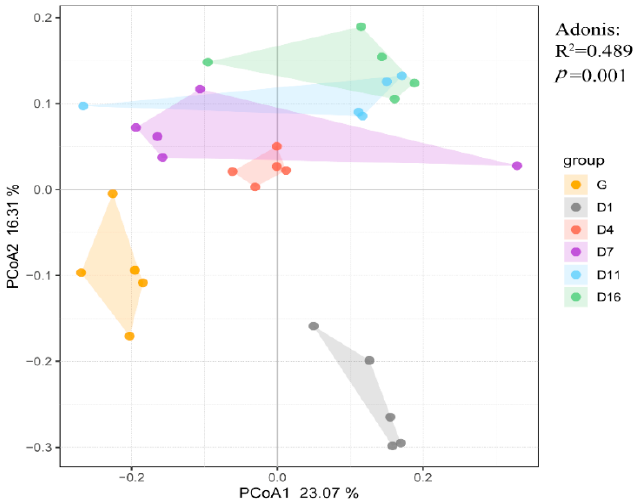
Figure 2. Principal coordinated analysis (PCoA) using Bray–Curtis dissimilarity, based on genus-level OTUs from yak fecal samples collected from the G (grazing) group and D1, D4, D7, D11, and D16 (feedlot feeding days 1, 4, 7, 11, and 16, respectively).